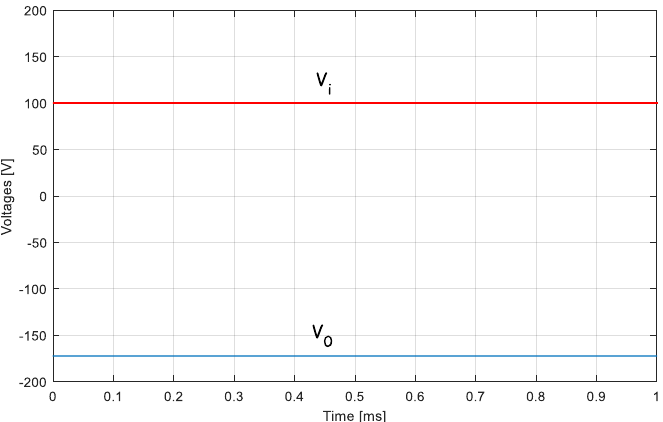
Figure 9. Simulation results of the input and inverted output voltage in boost mode.